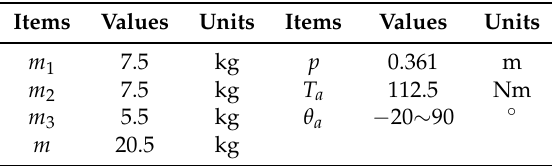
Table 2. General parameters of the manipulator. m 1 represents the mass of the shoulder joint; m 2 represents the mass of the wrist joint; m 3 represents the mass of the scissors joint; m represents the mass of the manipulator; p represents the location of the mass center; T a represents the maximum torque that the shoulder joint can bear; θ a represents the motion range of the shoulder joint.